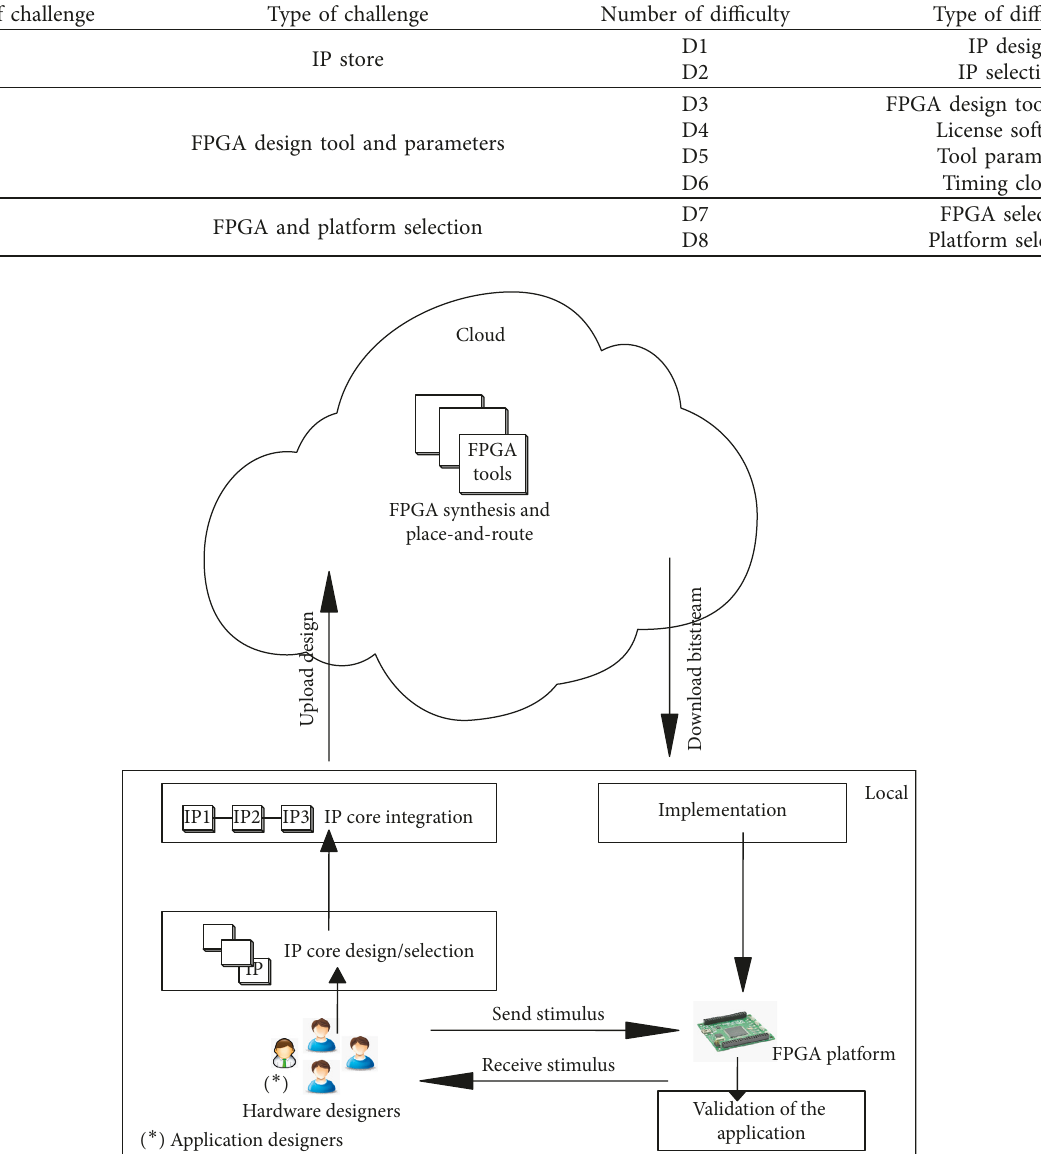
Figure 3: FPGA Tools as a Service model. The hardware designer accesses the cloud for all existing solution, except for the LabView tool, where the application designer can access the